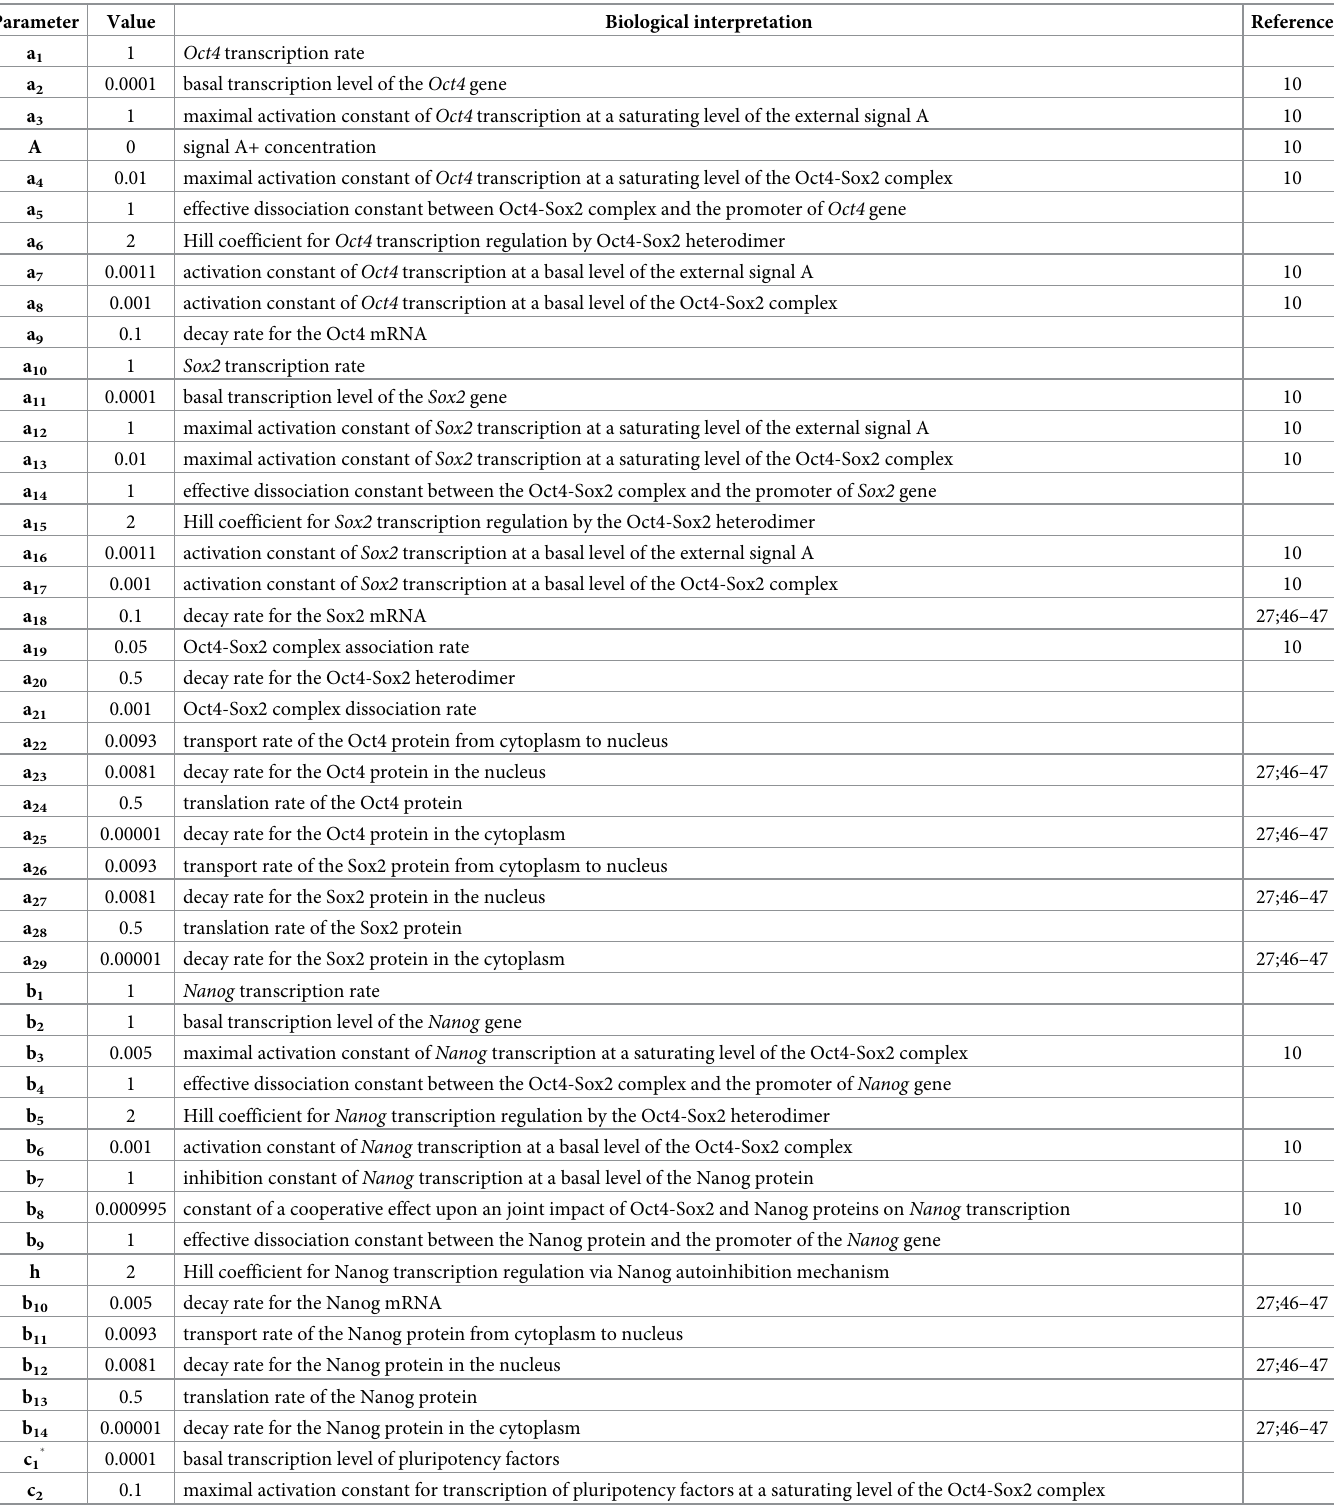
Table 1. Biological relevance and values of the model